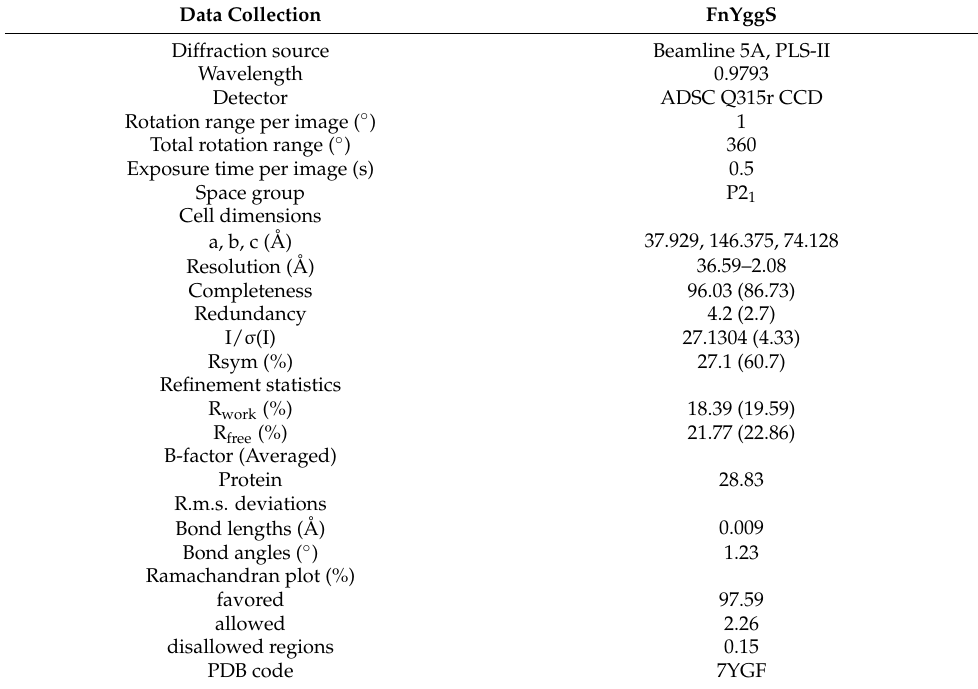
Table 1. Data collection and refinement statistics for